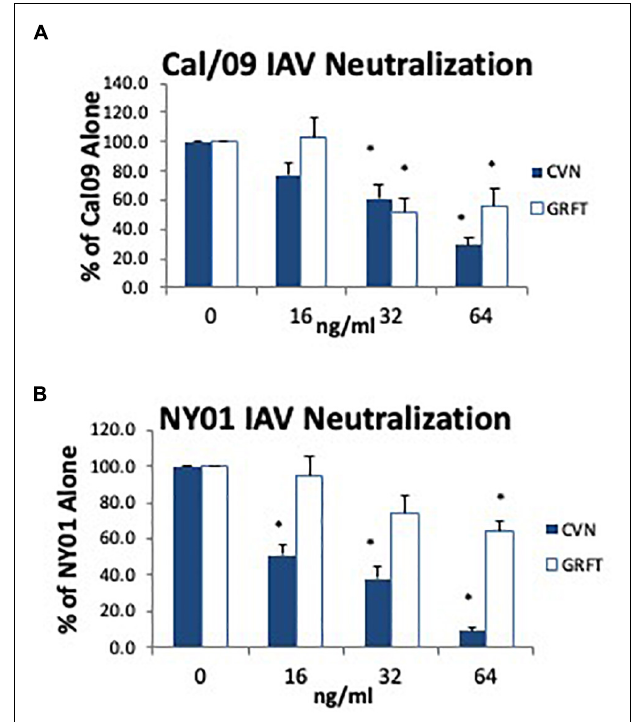
FIGURE 8 | Neutralizing activity of cyanovirin and griffithsin against Cal09 H1N1 or NY01 H1N1 viruses. The ability of cyanovirin and griffithsin to neutralize Cal09 (A) or NY01 (B) was tested at the indicated concentrations in ng/ml ( ∗ p < 0.05 vs. control; mean ± SEM; n =